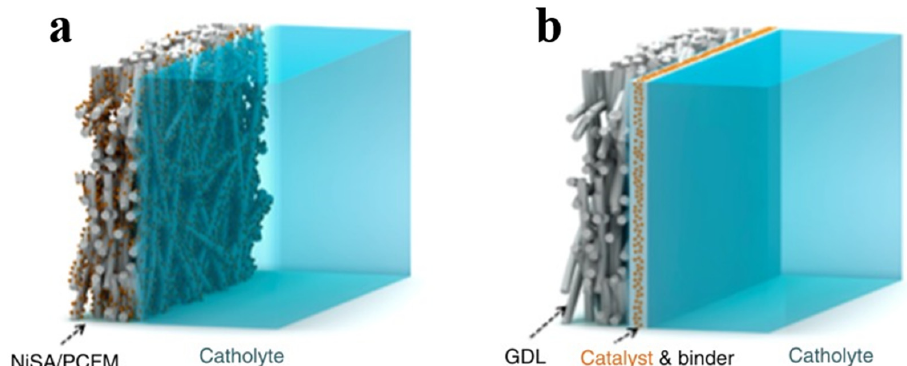
Figure 14. ( a ) Typical GDE loaded with catalyst via polymer binder. ( b ) Ni single-atom/porous car- bon fiber membrane used as integrated GDE. Reproduced with permission from Ref. [94]. Copy- right 2020 Springer Nature